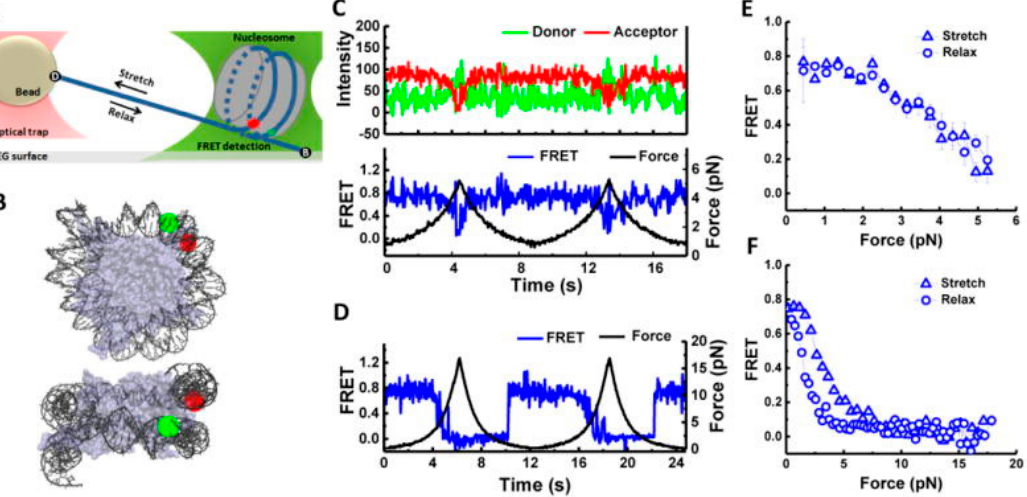
Figure 5. Combination of smFRET and force measurements to understand the conformational changes of the nucleosome under tension. ( A ) Scheme: Nucleosome was attached to the microscope via a dsDNA extension. The other end of the DNA was held by an optical trap that applies force. Green and red dots denote the positions of donor and acceptor dye, respectively. Local conformational changes were monitored through FRET between the donor (Cy3) and acceptor (Cy5). ( B ) Two different views of the labeling positions for the smFRET measurement. Nucleosome structure file: PDB, 3MVD. ( C ) Representative traces for smFRET measurement and force measurement at a stage speed of 455 nm/s with maximum force set at ~6 pN. Top: smFRET trace; green and red denote the donor and acceptor emissions, respectively. Bottom: overlap of FRET efficiency (blue) and force (black). ( D ) Overlap of smFRET (blue) and force (black) time traces similar to ( C ) with a maximum force set at ~20 pN. ( E ) Average FRET vs. force plot when maximum force was ~6 pN. ( F ) Average FRET vs. force plot when maximum force was ~20 pN. Figure is adapted from [86] with permission.